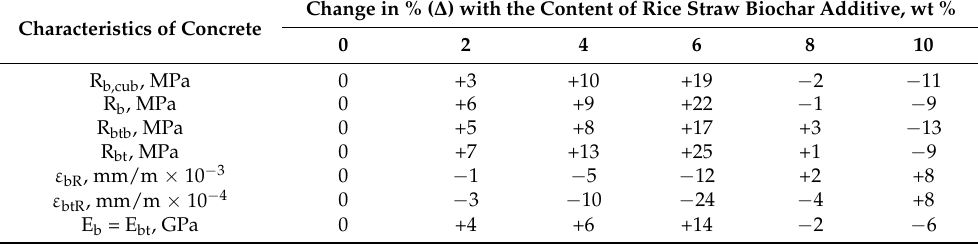
Table 4. Changes in the strength and deformation characteristics of test samples of heavy concrete depending on the content of rice straw biochar additive ( ∆ ).